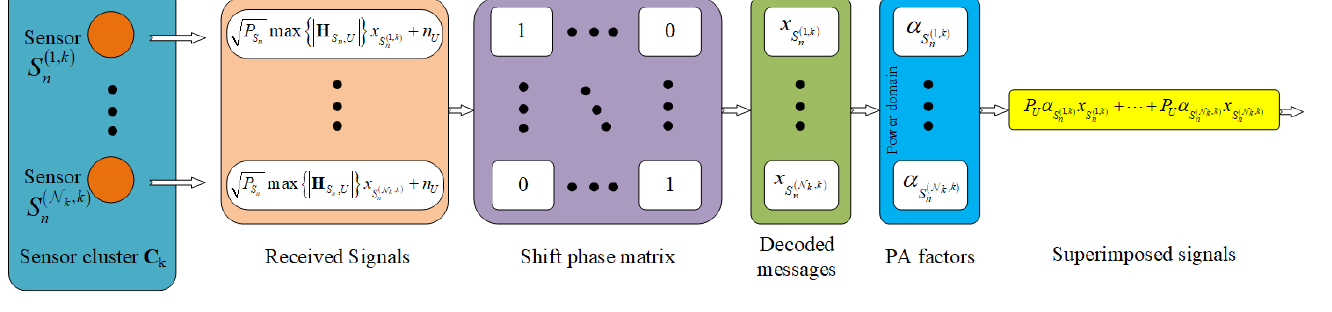
Figure 6. Procedure of processing data at the